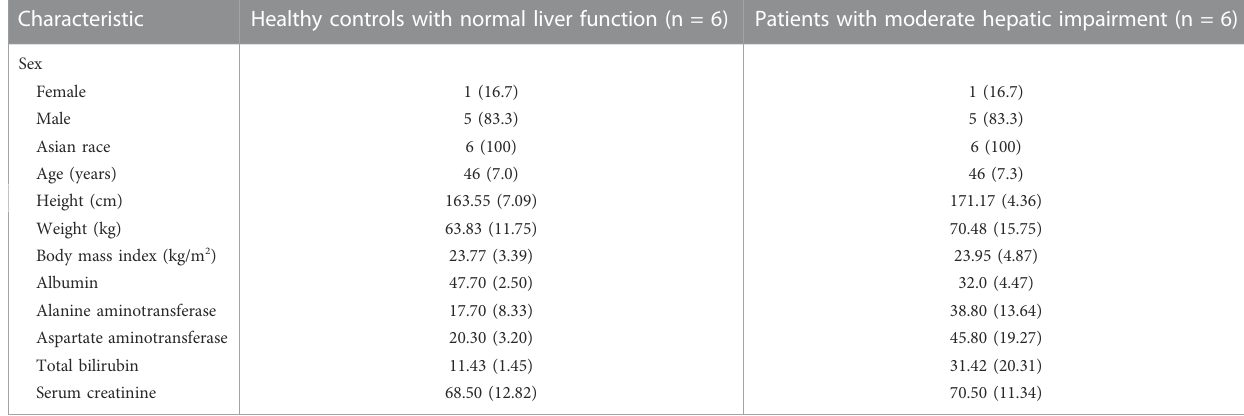
Data are presented as number (%) or mean (standard deviation) unless otherwise speci fi ed.